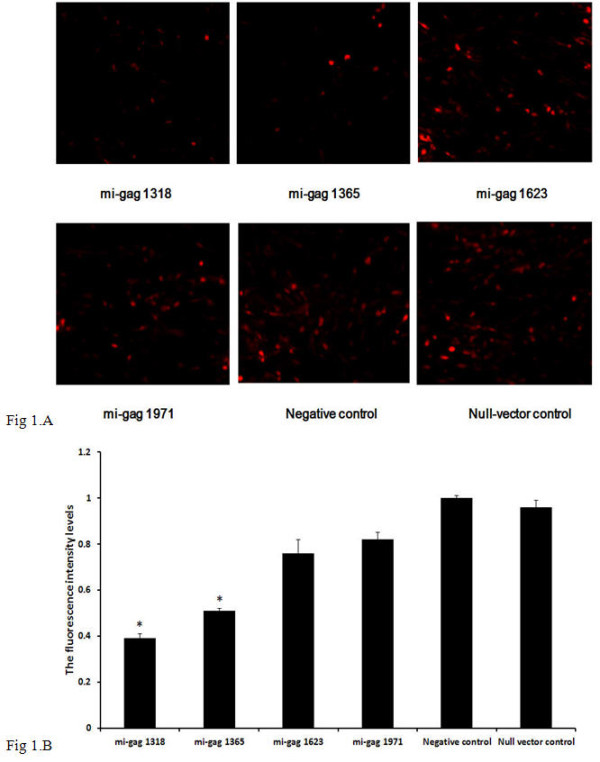
ALV-J replication. (A) Cells transfected with the recombinant plasmid pMD-G and their inhibitory effects against ALV-J, as determined by the IFA. (B) The fluorescence intensity of cells transfected with the recombinant plasmid pMD-G and their inhibitory effects against ALV-J, as determined by the IFA. Data are presented as means±S.E.M. of three independent experiments, each performed in triplicate. *Statistically significant differences compared with negative controls (P<0.05).